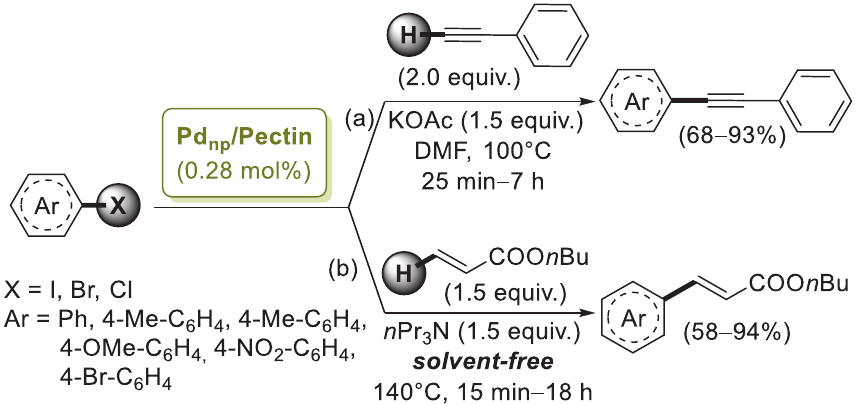
Figure 3. Chemical structure of pectin.